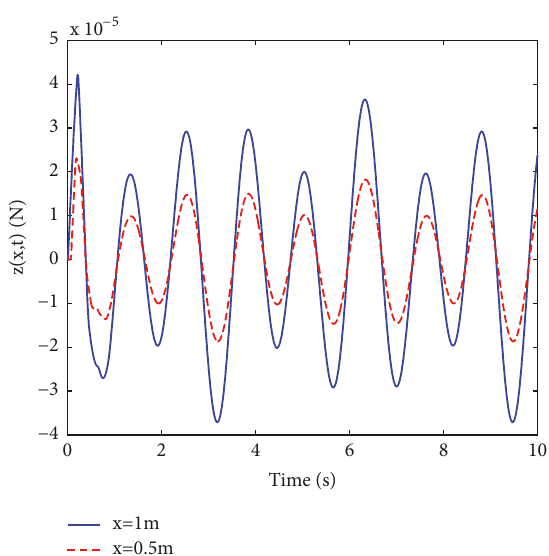
Figure 5: Two-dimensional deflection of the string with